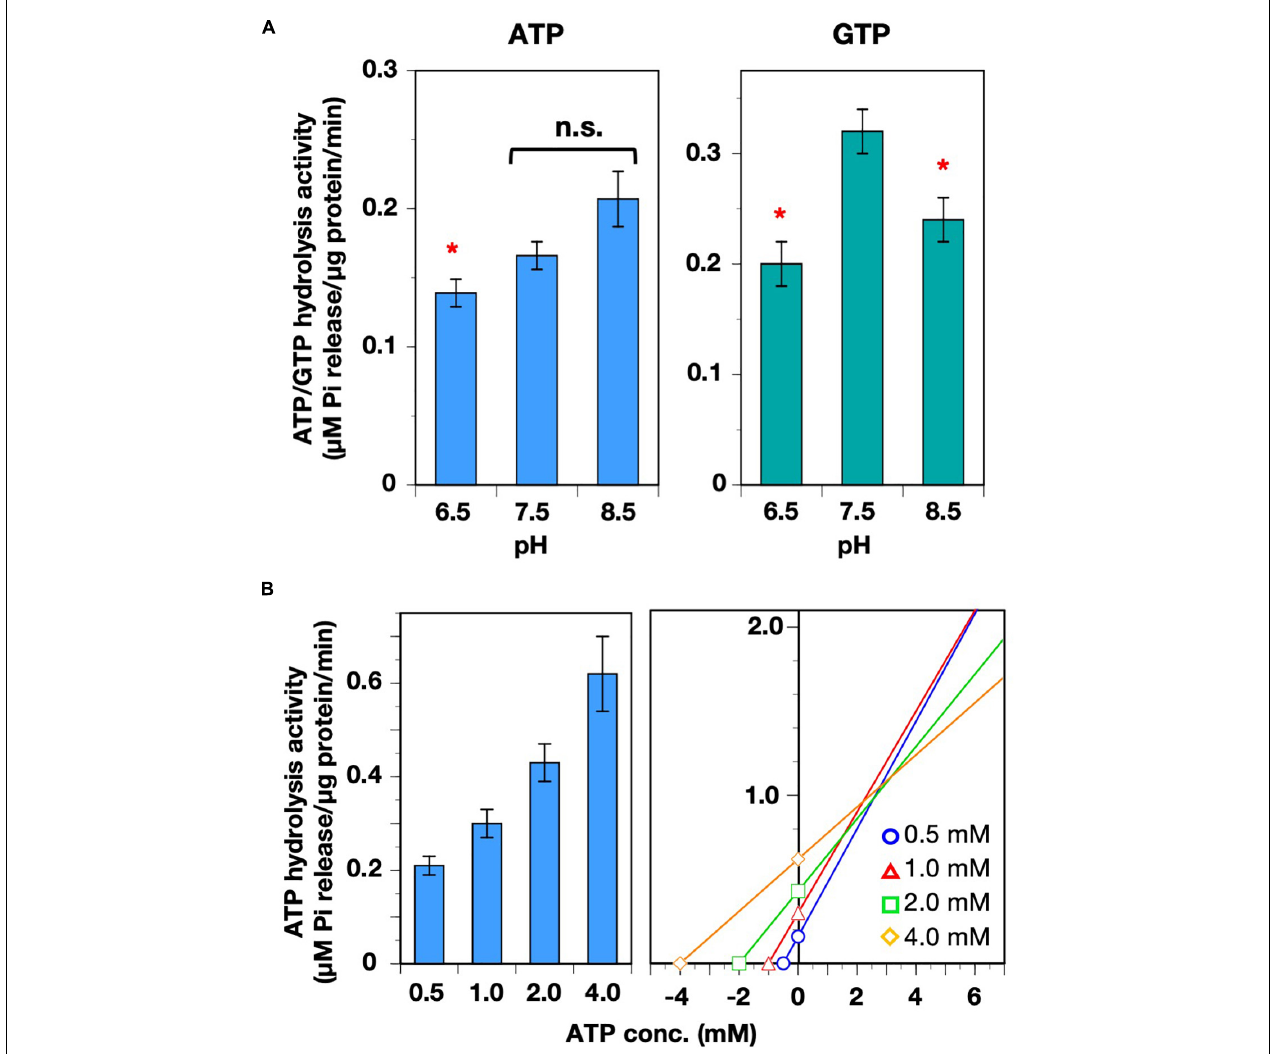
FIGURE 3 | Characterization of ATP hydrolysis activity. (A) The pH preferences of both ATP- and GTP-hydrolysis activities were analyzed. Asterisks denote significant differences in the activity from those at pH 7.5 (Welch’s t-test with p < 0.01). (B) Analyses of V max and K M of the ATP hydrolysis activity. ATP hydrolysis activity was measured in the presence four ATP concentrations (0.5–4.0 mM). Each bar graph and error bar represents the means and SD, respectively, of results from 5–9 independent experiments (left graph). The concentration of ATP and the average of VIPP1-dependent Pi release are plotted on the graph in accordance with the Cornish–Bowden plot method. The X and Y values of the intersection points represent K M and V max , respectively (right